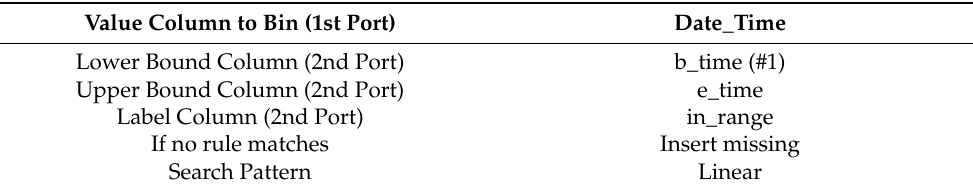
Figure 2. Sub-workflow for time window filter Meta node. Table 2. Configuration to extract data for start and end time.